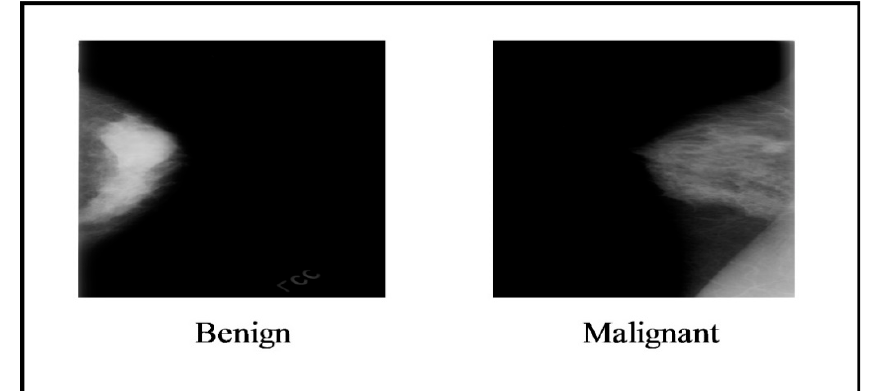
Figure 2. Sample images of the CBIS-DDSM dataset [38] .